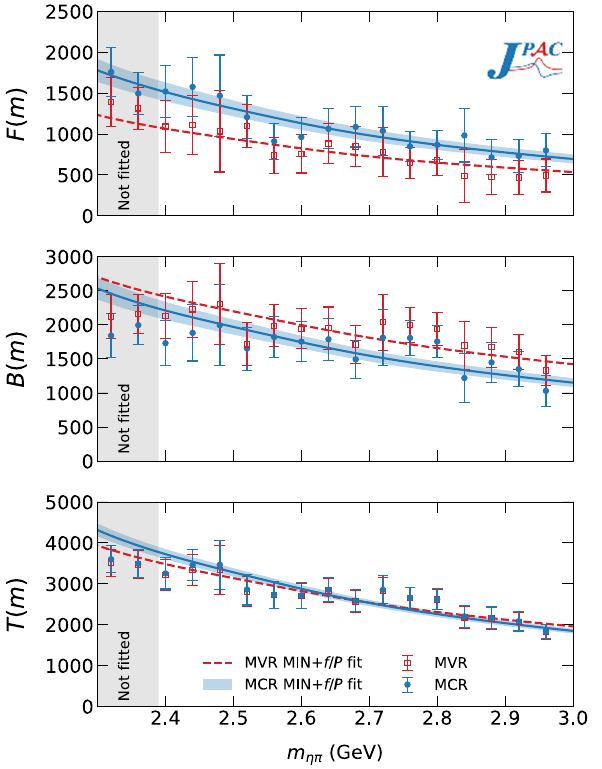
Fig. 21 Same as Fig. 20 for the η (cid:2) π data and the MIN + IP / IP